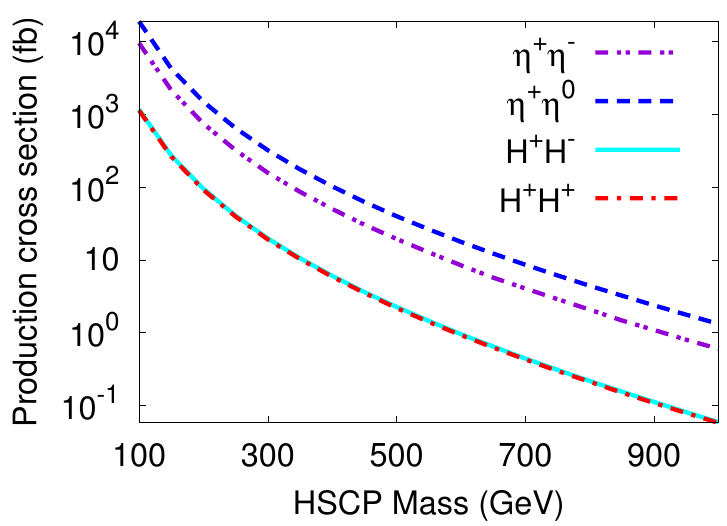
Figure 3 . Production cross-section of heavy stable charged particles (HSCP) of Type III Seesaw model and IDM at the 14 TeV LHC. Here dashed blue line also includes the production cross-section of (cid:17) (cid:0) (cid:17) 0 and dot-dashed red line shows the cross-section for H (cid:6) H (cid:6)